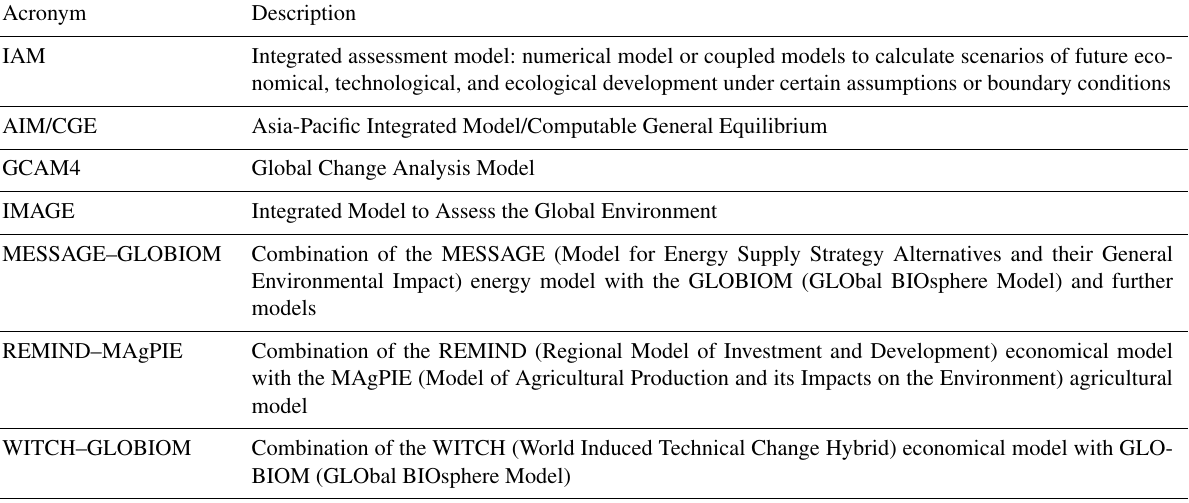
Table A2. Integrated assessment model (IAM) acronyms used in this paper.